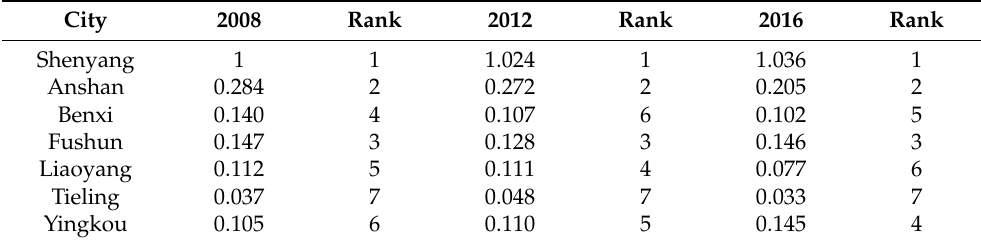
Table 5. Gross sizes of cities.